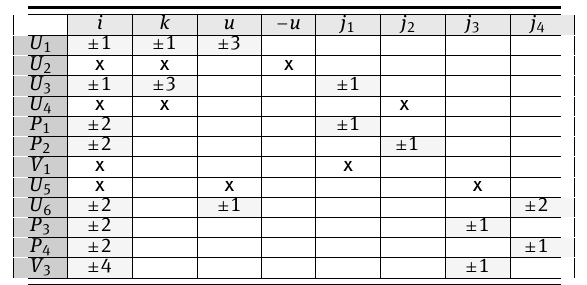
Table 12. Index distribution on B i ∪ C i ∪ D i ∪ E i and on 4 words of type [± 2, ± 1 ] .